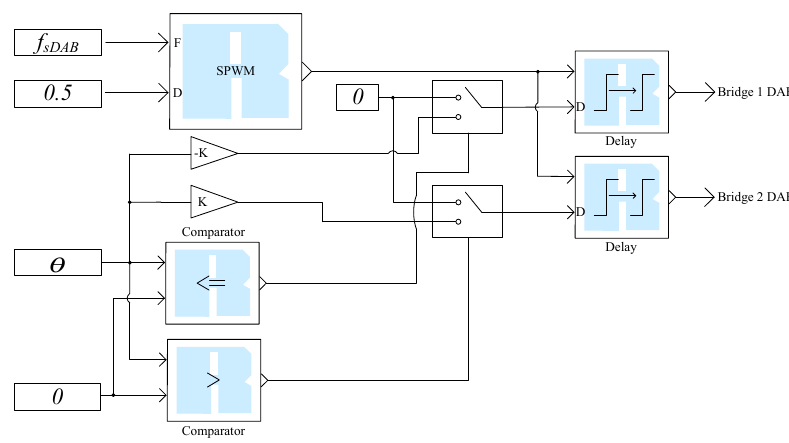
Figure 7. Proposed DAB modulation scheme.